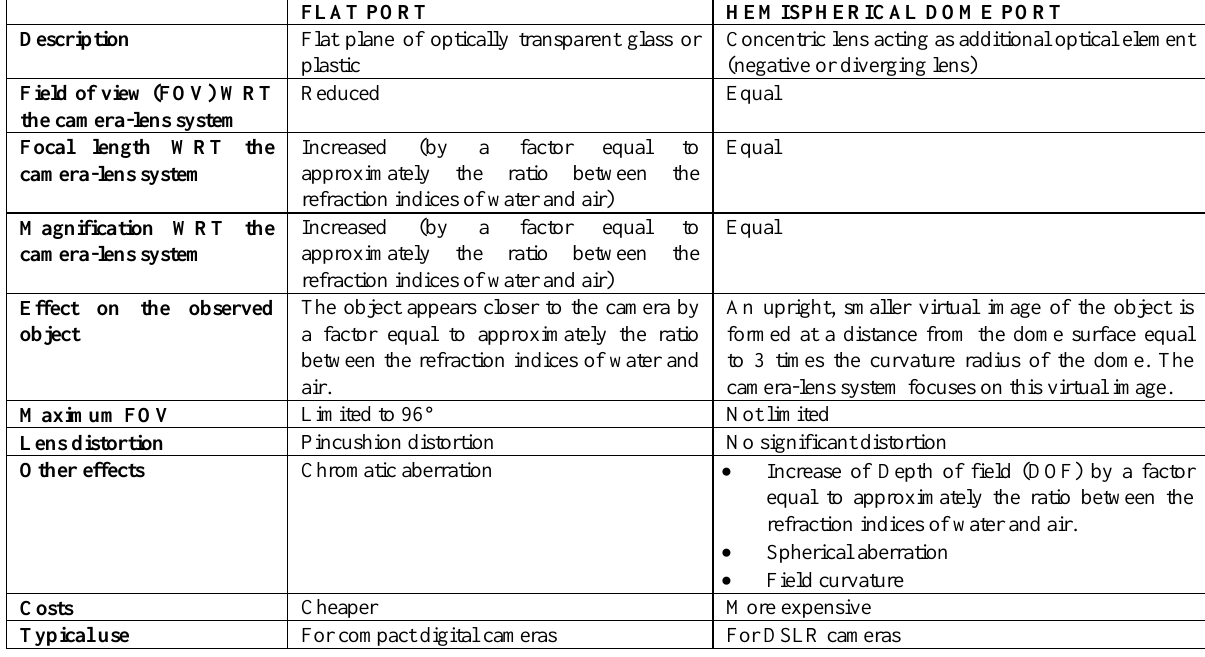
Table 1. Characteristics of flat and dome ports.